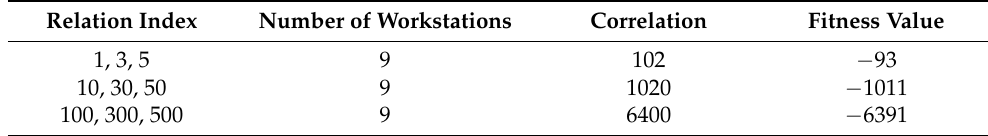
Table 4. Results analysis over the relation index changes.